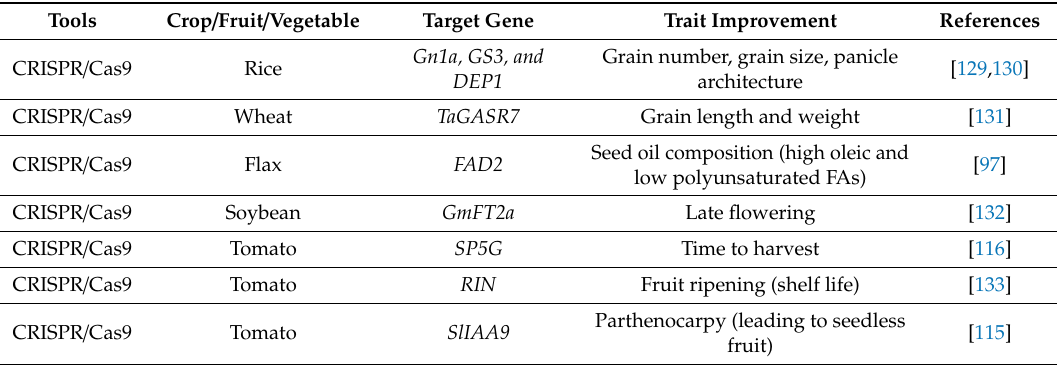
Table 3. Improvement in the yield and quality of crops, fruits, and vegetables via